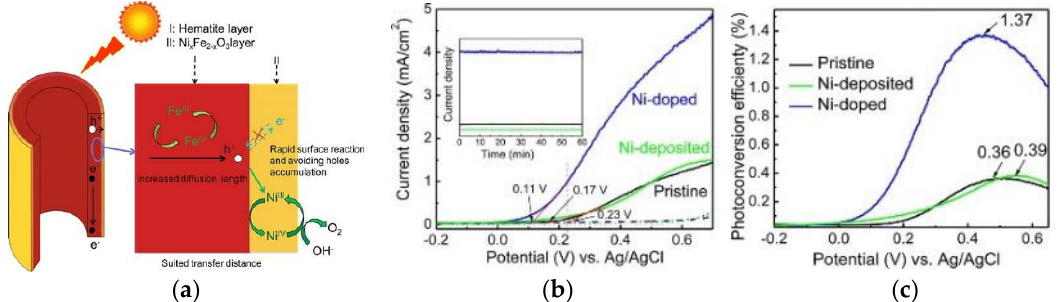
Figure 7. ( a ) Schematic of the OER process taking place at the hematite photoanode. In the sketch map, it only shows the OER process occurring on the outside surface of the hematite nanotube wall covered with the Ni x Fe 2 − x O 3 thin layer. The authors admitted that the same process also occurs on the inside surface; ( b ) current density (inset: Photochemical stability curves); and ( c ) incident photon-to-current conversion efficiency (IPCE) curves of the pristine, Ni-deposited and Ni-doped samples. Reprinted with permission from Reference [66], copyright (2012) American Chemical Society. Table 5. List of surface doping for surface modification on hematite nanostructures.